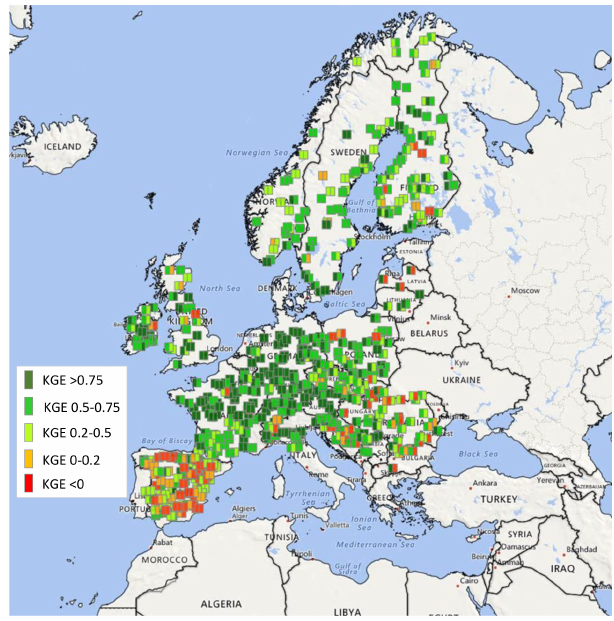
Figure B1. Hydrological skill of EFAS at the calibration loca- tions. Colour coding denotes the quality of the KGE during cali- bration (left half of square) and validation (right half of the square). Adapted from Arnal et al.